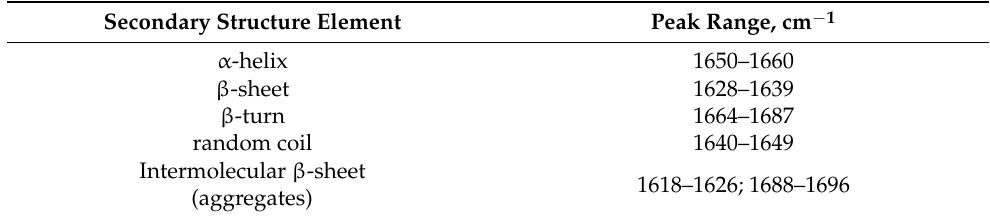
Table 3. Correlation between secondary structure element in BSA and Amide I second derivative position 1 .